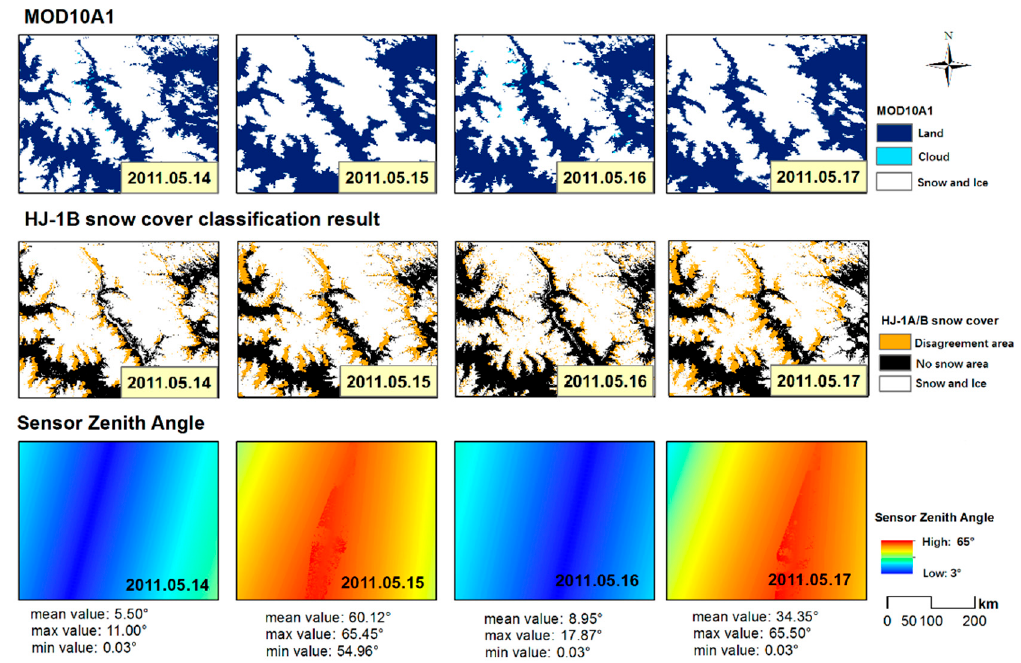
Figure 2. Comparison of snow cover maps produced by MOD10A1 and HJ-1A/B satellite data, and corresponding sensor zenith angle (SZA) values in a typical area of the Tarim River Basin on 14–17 May 2011.